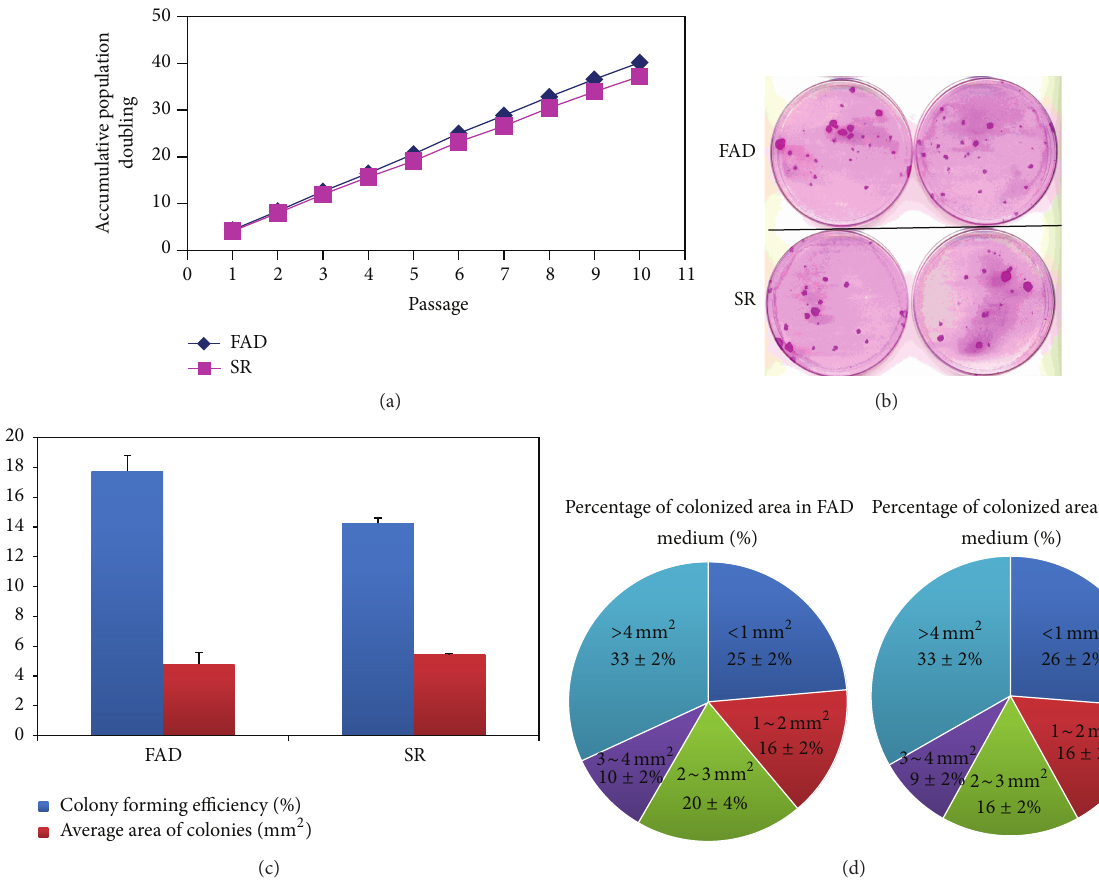
Figure 2: Comparison of cell population doubling (PD) and colony forming efficiency (CFE) of human limbal epithelial cells cultured in SR and FAD media. (a) Human limbal epithelial cells were serially subcultured in SR medium and FAD medium for 10 passages ( 𝑛 = 5 ); cell population doublings (PD) number and accumulated PD were calculated and plotted. PD was calculated according to the following formula: PD = ( log 𝑁/𝑁 0 )/ log 2 , where 𝑁 represents the total number of cells obtained at each passage and 𝑁 0 represents the number of plating cells at the beginning of each passage. (b) To analyze the CFE, limbal epithelial cells were seeded at a density of 200 cells per 100 mm petri dish in SR and FAD media and allowed to grow for 12 days. (c) CFE values for epithelial cells in SR and FAD media were 17 % ±2.5 % and 15 % ±3.1 %, respectively. No differences of CFE were found between SR medium and FAD medium group ( 𝑝 > 0.05 , 𝑛 = 5 ). (d) Percentage of colonized area in FAD was close to that of SR medium. The limbal epithelial cells maintained in SR medium exhibited similar CFE and colony size compared to cells maintained in FAD